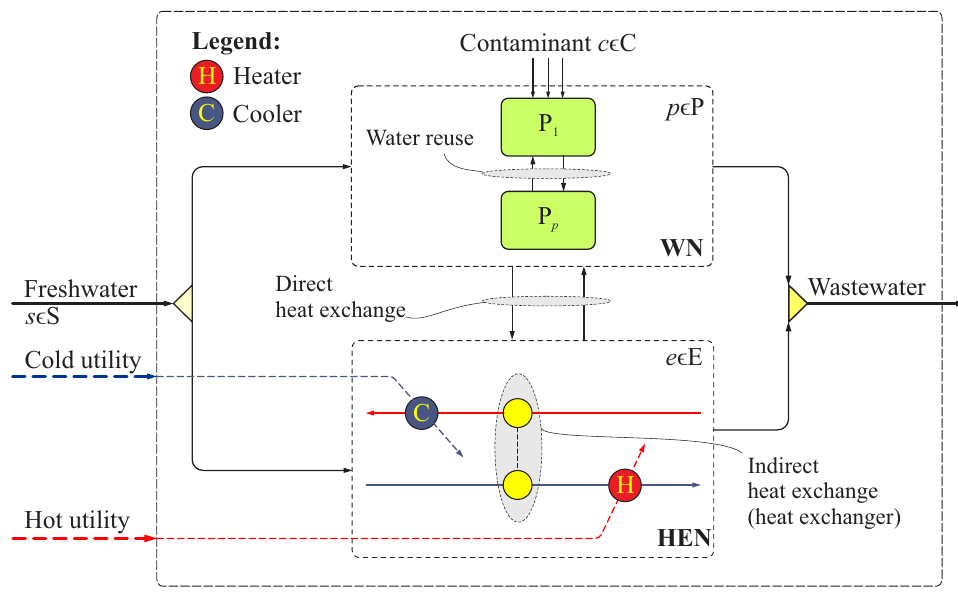
Figure 1. A schematic representation of the HIWN